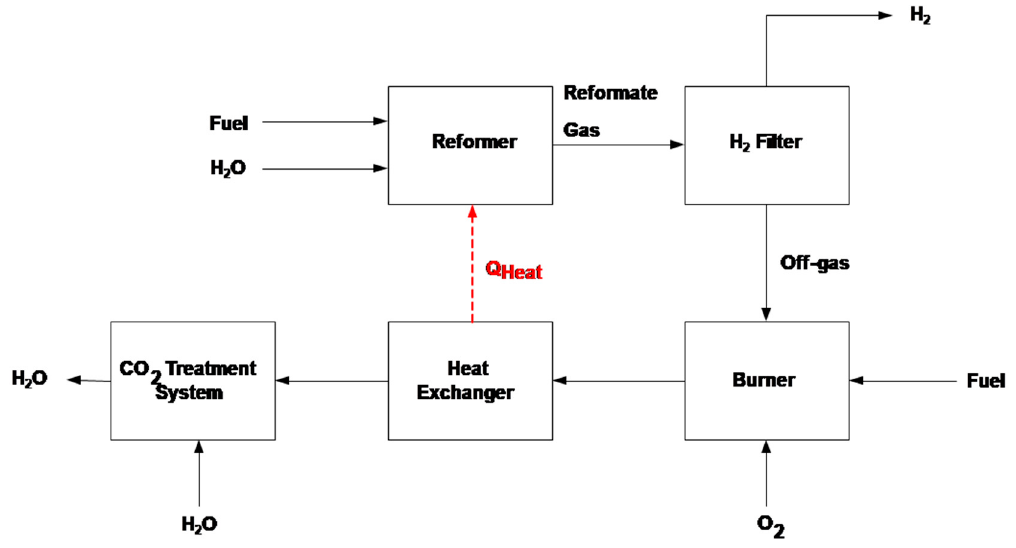
Figure 1. Block flow diagram for fuel reformer